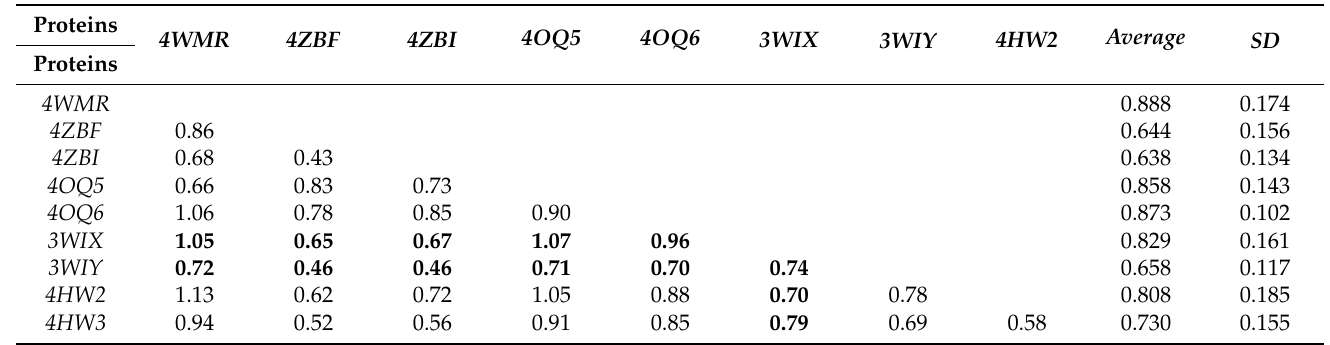
Table 2. MRC approach: superposition of backbone of multiple hMcl-1 from various crystal structures and their calculated RMSD values (Å).